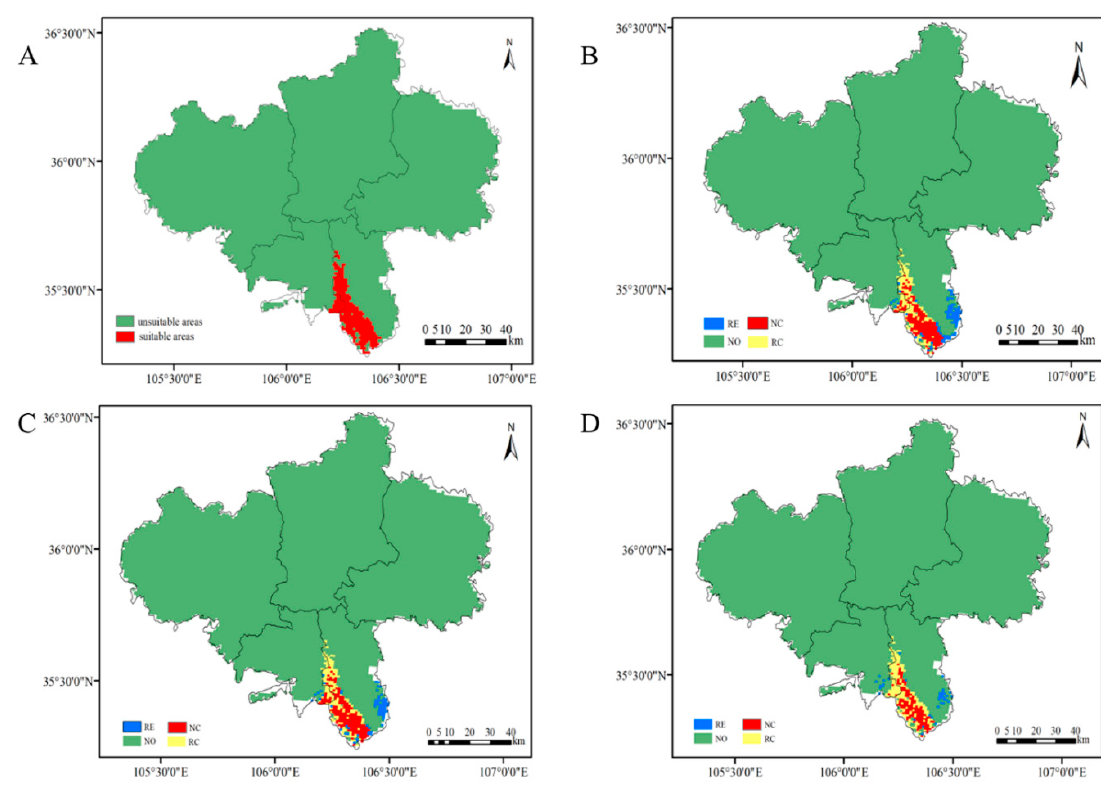
Figure 5. Prediction of changes in suitable habitat areas of leopards under different climate models. ( A ). The modern leopard is suitable for habitat distribution. ( B ). The leopard is suitable for habitat distribution under the future rcp2.6 climate model. ( C ). The leopard is suitable for habitat distribution under the future rcp4.5 climate model. ( D ). The leopard is also suitable for habitat distribution under the future rcp8.5 climate model. RE = range expansion; NO = no occupancy; NC = no change; RC = range contraction. Core area is the area where the suitable habitat of the leopard does not change compared with the suitable habitat in modern Guyuan under different climate models in the future. Expanded habitat is the area where the suitable habitat of the leopard in the future under different climate models expands compared with the habitat in modern Guyuan. Shrunk habitat